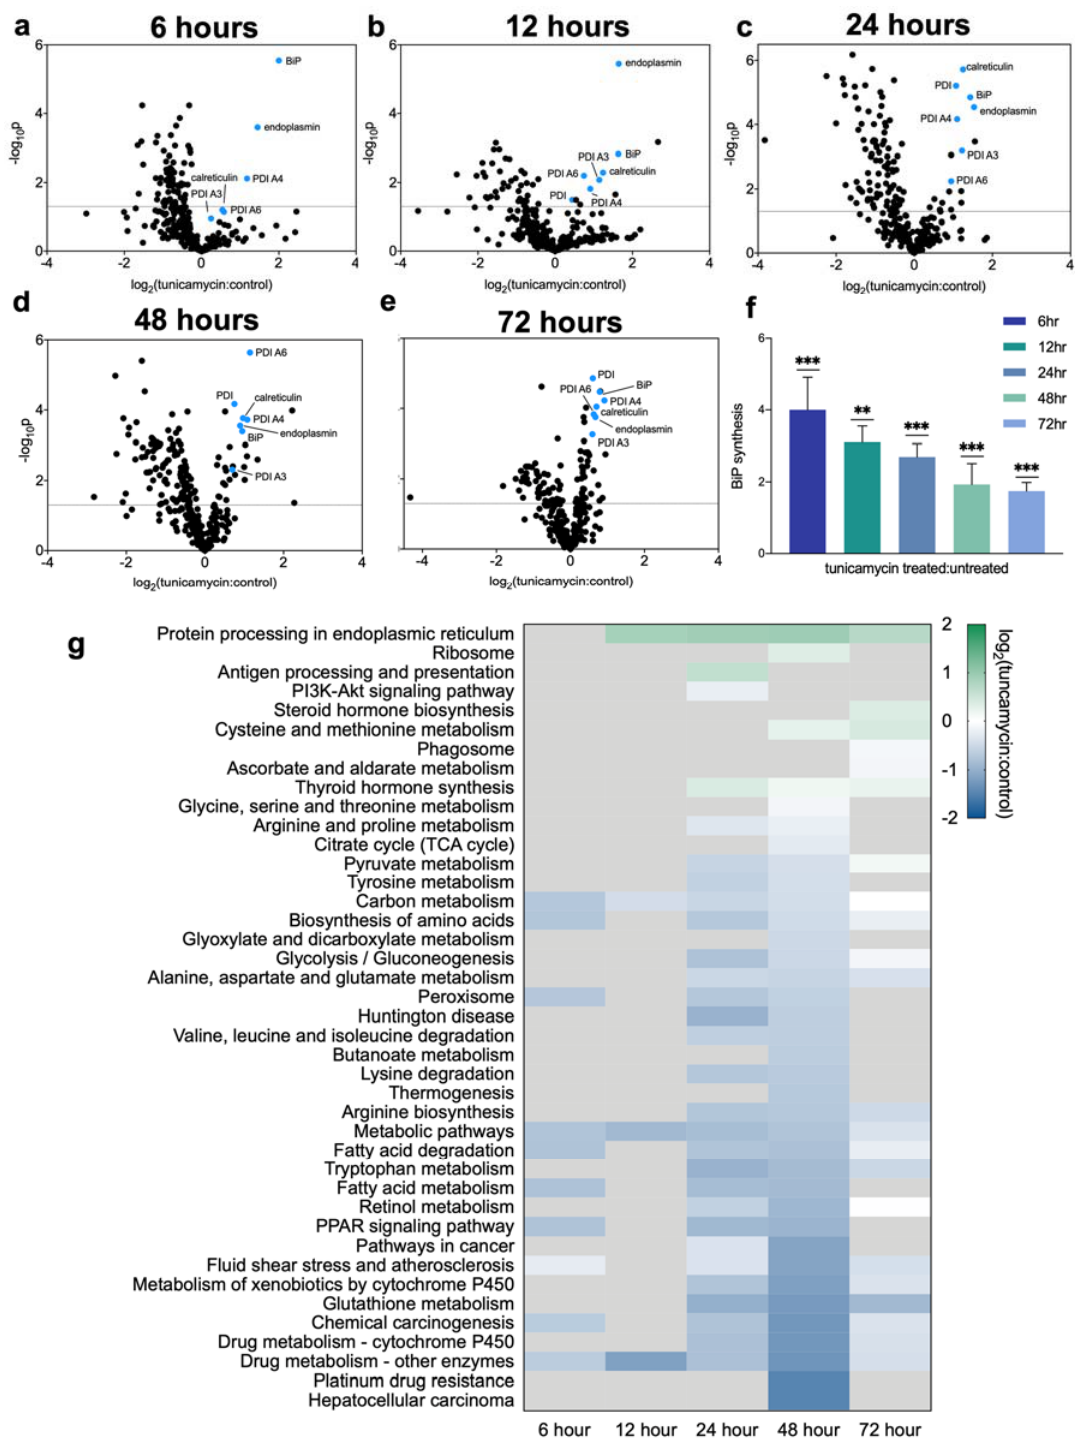
Figure 2. ( a – f ) Volcano plot of all proteins for which fractional synthesis rates were measured 12–72 h post tunicamycin treatment. Points expressed as log2 fold-change tunicamycin treated/control on x -axis and − log10 ( p -value), obtained from 2-tail t -test, on y -axis. ( f ) Ratio of protein translation rates of BiP in tunicamycin treated/control. Ns = no significance, ** = <0.01, *** = <0.001. ( g ) KEGG- pathway analysis for fractional synthesis rates of significant ( p = <0.05 per 2-tail t -test) proteins from tunicamycin treated/control. n = at least 5 proteins per pathway. All protein abbreviations used are consistent with Uniprot; accession numbers can be found in the Supplementary Tables.